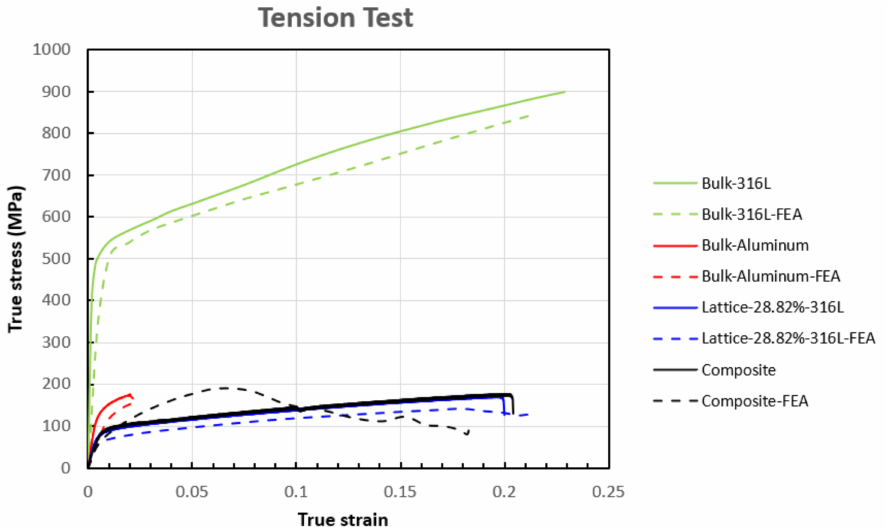
Figure 16. Comparison between experimental and FEA results of bulk 316L stainless steel, bulk dissolvable aluminum 316L stainless steel lattice, and 316L stainless steel/dissolvable aluminum composite for the tension